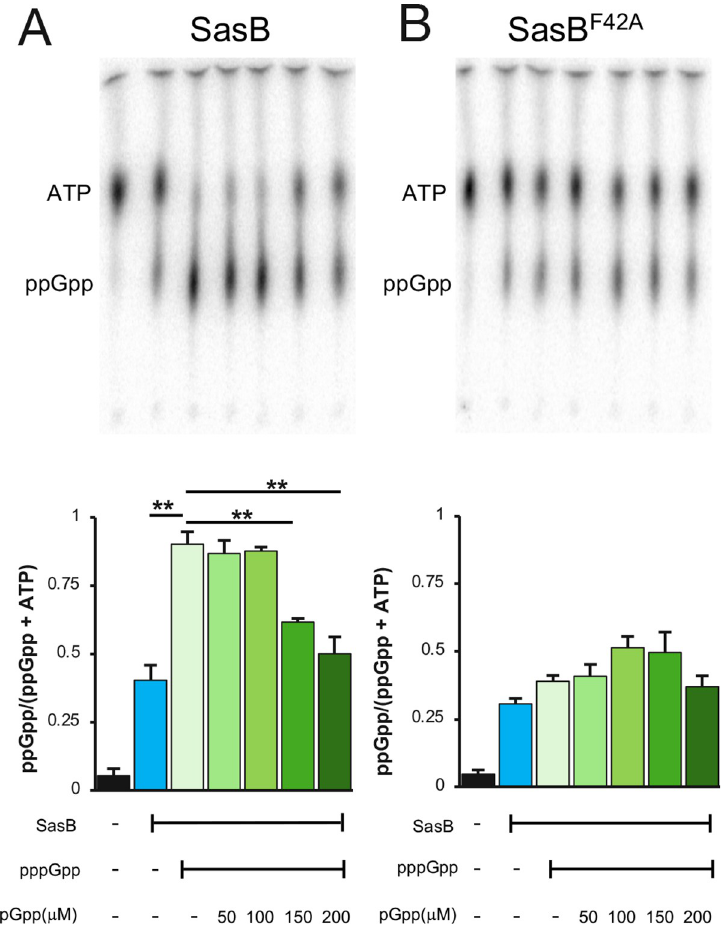
Fig 4. pGpp inhibits the allosteric activation of SasB by pppGpp. (A) Representative TLC of nucleotides present following incubation of wildtype SasB with [ α - 32 P]-ATP and GDP in the presence or absence of pppGpp and increasing concentrations of pGpp ( μ M) (top). Quantitation of the ratio of ppGpp to total nucleotides present in each lane in TLC. This ratio was calculated using the formula: ppGpp/ATP + ppGpp (bottom). (B) Representative TLC of nucleotides present following incubation of SasB F42A with [ α - 32 P]-ATP and GDP in the presence or absence of pppGpp and increasing concentrations of pGpp (top). Ratio of ppGpp present in each lane in TLC as determined the formula, ppGpp/ATP + ppGpp (bottom). Statistical analysis (two tailed t-test) showed no significance (p > 0.05) between reactions containing SasB in the presence or absence of pppGpp and/or pGpp. should be dominant to a Δ sasA mutation. Consistently, the population of "OFF" cells in a Δ sasA strain was absent in a strain lacking both SasA and SasB ( Δ sasA Δ sasB ) (Fig 5A and 5B). Thus, the effect of SasA is dependent in vivo on SasB. Finally, since RelA activates SasB, a relA mutation should be dominant to a Δ sasA mutation. Consistently, a strain expressing RelA Y308A and carrying a Δ sasA mutation exhibited a loss of heterogeneity in protein synthesis similar to the relA Y308A strain, demonstrating that the effect of the Δ sasA mutation depends on a func- tional RelA synthase (Fig 5A and 5C). Since pGpp also accumulates in stationary phase cells as a result of degradation of both ppGpp and pppGpp by the hydrolase NahA [14,20], we asked if NahA contributes to the heterogeneity in protein synthesis by comparing OPP incorporation in wildtype and Δ nahA cells during late transition phase. Since we observed no difference in heterogeneity (S4 Fig), SasA is the primary regulator of heterogeneity under our experimental conditions.